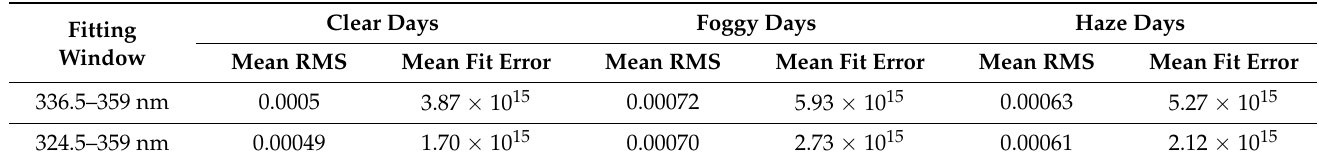
Table 3. Mean RMS and mean fit error at different fitting windows during different meteorological conditions.